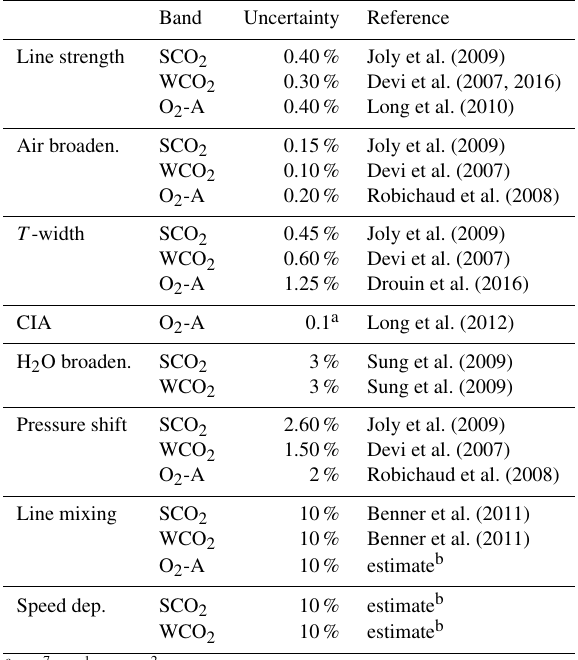
Table 1. Uncertainties in spectroscopic parameters used in the L2